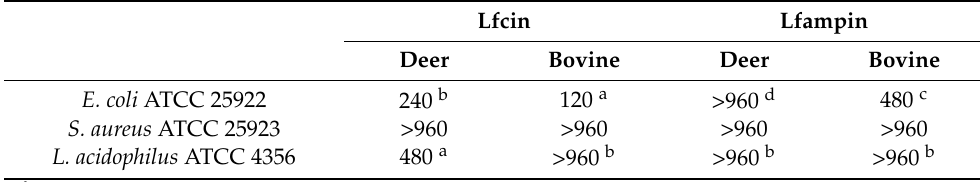
Table 2. Minimum Inhibitory Concentrations (MIC) ( µ g/mL) of deer and bovine lactoferricin (Lfcin) and lactoferrampin (Lfampin) against E. coli ATCC 25922, S. aureus ATCC 25923, and L. acidophilus ATCC 4356. The Minimum Bactericidal Concentrations (MBC) values were found to be the same as that of the MIC values. Lfcin Lfampin Deer Bovine Deer